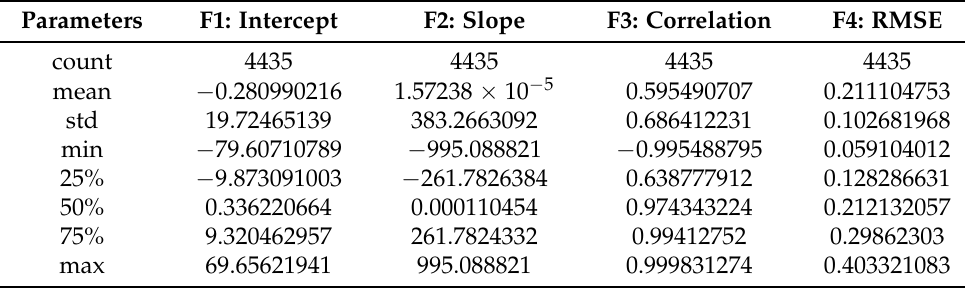
Table 3. Statistical information of ZCP dataset with THD level from 10% to 50%. Parameters